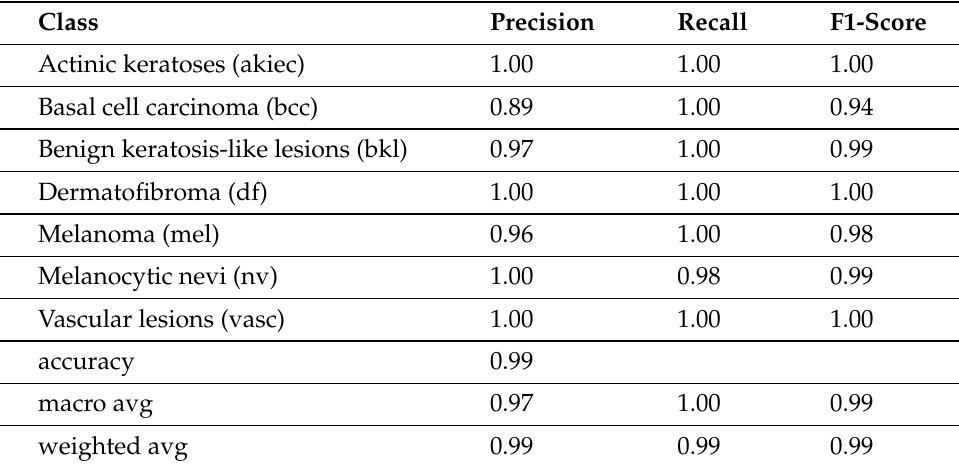
Table 7. Detailed results of each classes in skin disease classification. Class Precision